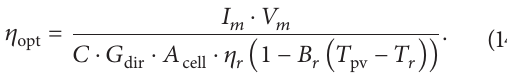
Figure 9: Fill factor of PV on different PV temperatures.